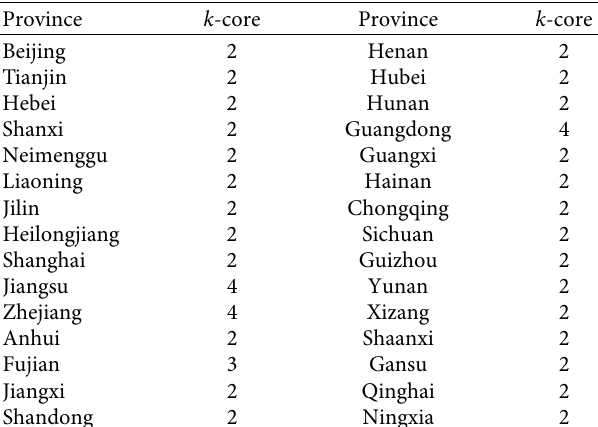
Figure 8: The transform from layer 1 to layer 2 and layer 2 to layer 3: the transform of investment to patent as shown in the between investment and patent; the transform of patent to production as shown in the between patent and production. Table 1: The k -core of each node of coupling four layers.